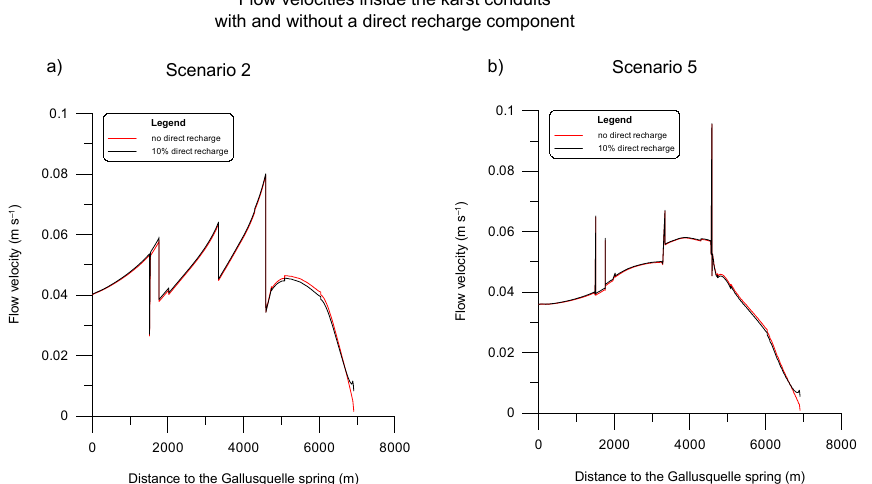
Figure 11. Flow velocities inside the main conduit branch of the Gallusquelle spring during the simulation of tracer test 2. The best-fit simulations for scenarios 2 and 5 are compared to simulations where a direct recharge of 10% is